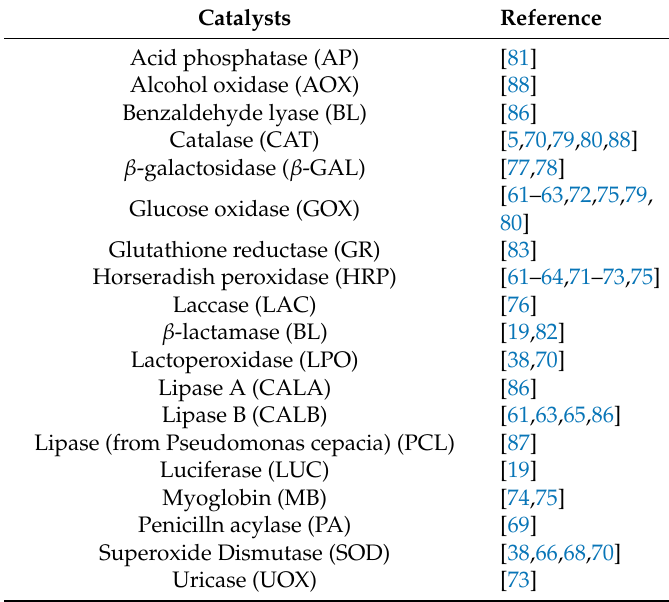
Table 1. List of enzymes encapsulated in polymer capsules.